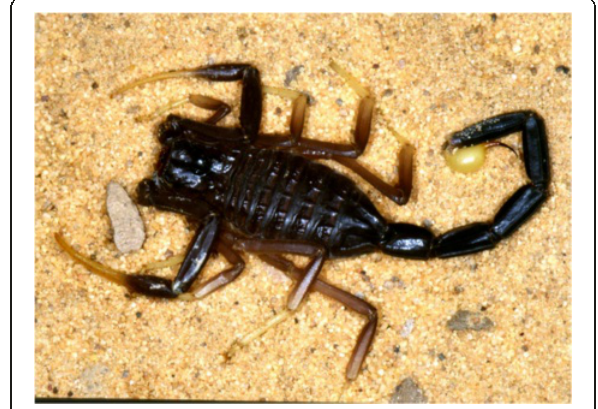
Fig. 8 Leiurus jordanensis Lourenço, Modry, Amr, 2002; female from